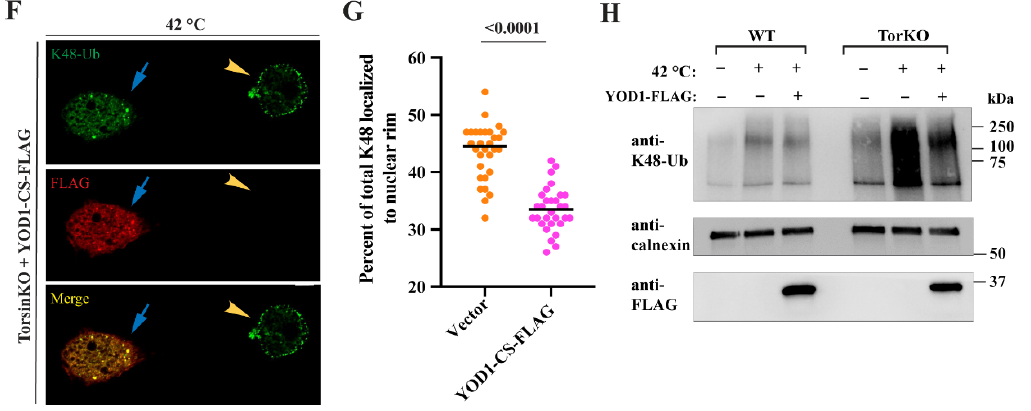
Figure 4. NE blebs in Torsin ‐ deficient cells sequester ubiquitylated proteins that are produced by heat shock stress. ( A ) Representative IF images of NE ‐ associated K48 ‐ Ub foci in TorsinKO cells upon heat shock. Cells were cultured at 37 °C or 42 °C for 16 h before processing for IF. Cells were stained with an antibody against K48 ‐ Ub and Mab414, which recognizes a subset of FG ‐ nucleoporins. Scale bar, 5 μ m. ( B ) Quantification of the average intensity of K48 ‐ Ub signal inside blebs from TorsinKO cells exposed to 37 °C or 42 °C for 16 h. This value was quantified for 50 TorsinKO cells/condition. Statistical analysis was performed using a Mann–Whitney U test. ( C ) An immunoblot demonstrating the subcellular fractionation of TorsinKO cells. Cells were enriched for NE/ER fractions (indicated by the emerin antibody) that were free from significant nucleoplasmic contamination (indicated by the anti ‐ hnRNPA1 antibody). ( D ) NE/ER fractions from WT or TorsinKO HeLa cells under unstressed or heat shock stress conditions were analyzed by immunoblot with antibodies against K48 ‐ Ub and emerin. Cells were exposed to a 42 °C heat shock for 16 h before harvesting. ( E ) Unstressed or heat ‐ shocked WT and TorsinKO cells overexpressing MLF2 ‐ HA for 24 h were fractionated into ER/NE enrichments. The fractions were analyzed by immunoblot using. Note that p97 controls for protein loading in this immunoblot. The ratio of HA to p97 density was calculated for each lane. ( F ) Representative IF images of TorsinKO cells expressing YOD1 ‐ CS ‐ FLAG under heat shock stress as described in panel ( A ). Cells were transfected with YOD1 ‐ CS ‐ FLAG eight hours prior to the beginning of heat shock. Blue arrow, transfected cell. Yellow arrowhead, untransfected cell. Scale bar, 5 μ m. ( G ) Quantification of the percent of total K48 ‐ Ub signal that localize to the nuclear rim in TorsinKO cells upon 42 °C heat shock with or without YOD1 ‐ CS ‐ FLAG overexpression. This value was obtained for 30 cells/condition. Statistical analysis was performed using a Mann–Whitney U test. ( H ) WT and TorsinKO cells expressing WT YOD1 ‐ FLAG for 24 h were subjected to heat shock stress and enriched for ER/NE fractions. These fractions were compared by immunoblot to unstressed or heat ‐ shocked cells in the absence of overexpressed YOD1 ‐ FLAG.